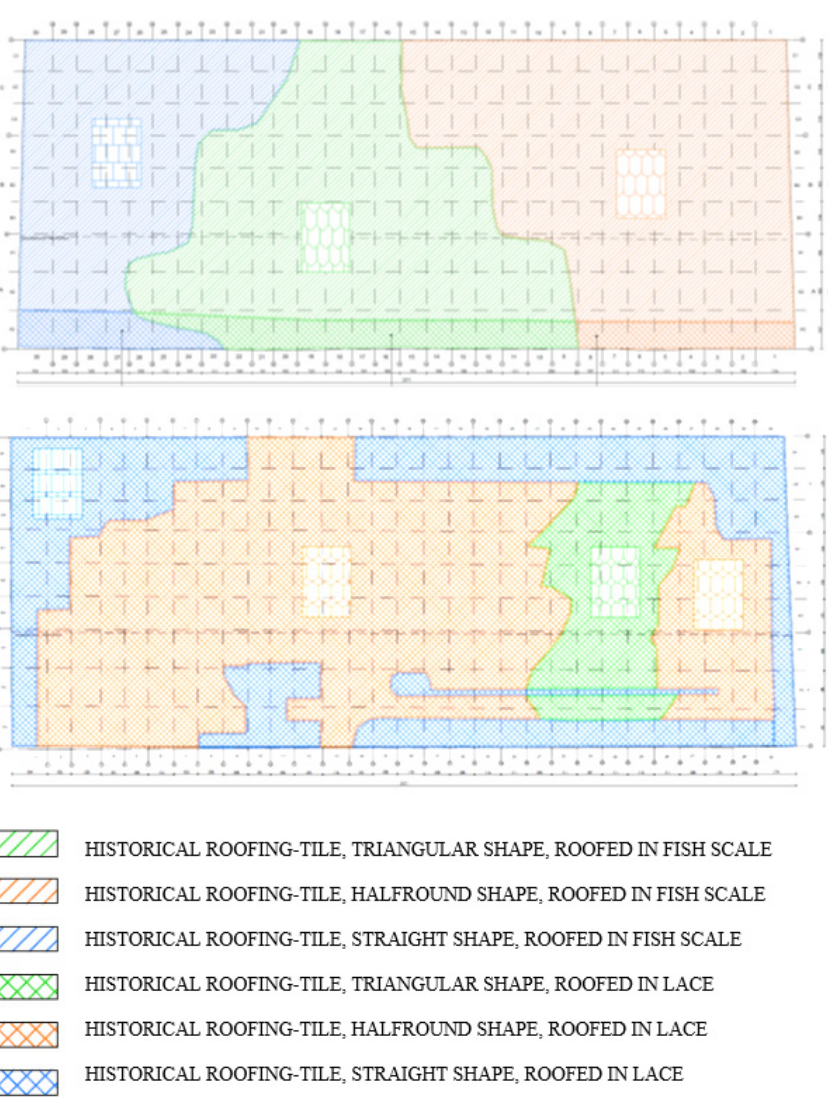
Figure 15. Arrangement of tiles on roof slopes.